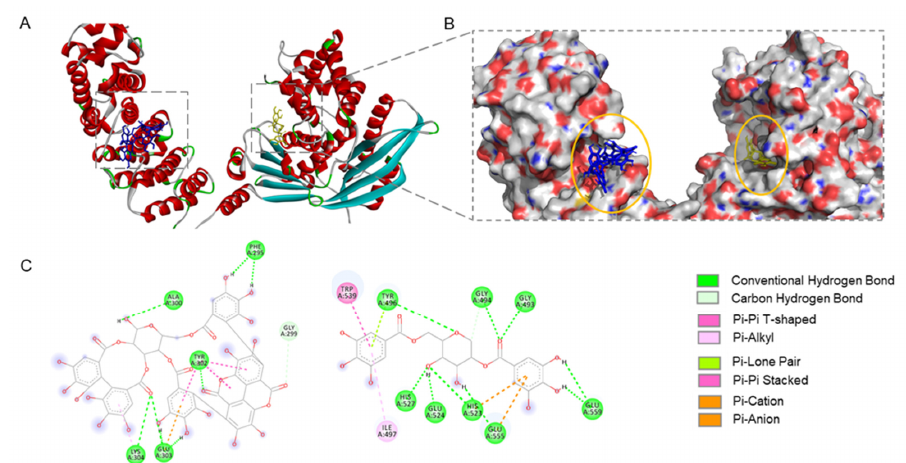
Figure 4. Molecular docking of the interactions between PA or GA and collagenase protein (PDB 2Y6I). Predicted binding sites of PA and GA on the two side chains of collagenase protein ( A ) and